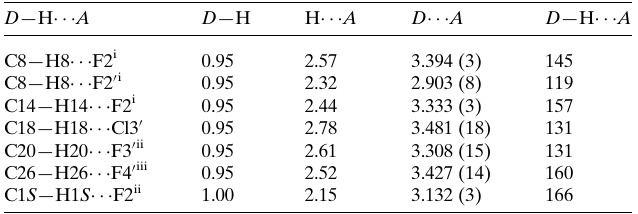
Table 1 Hydrogen-bond geometry (A˚ , (cid:4) ).